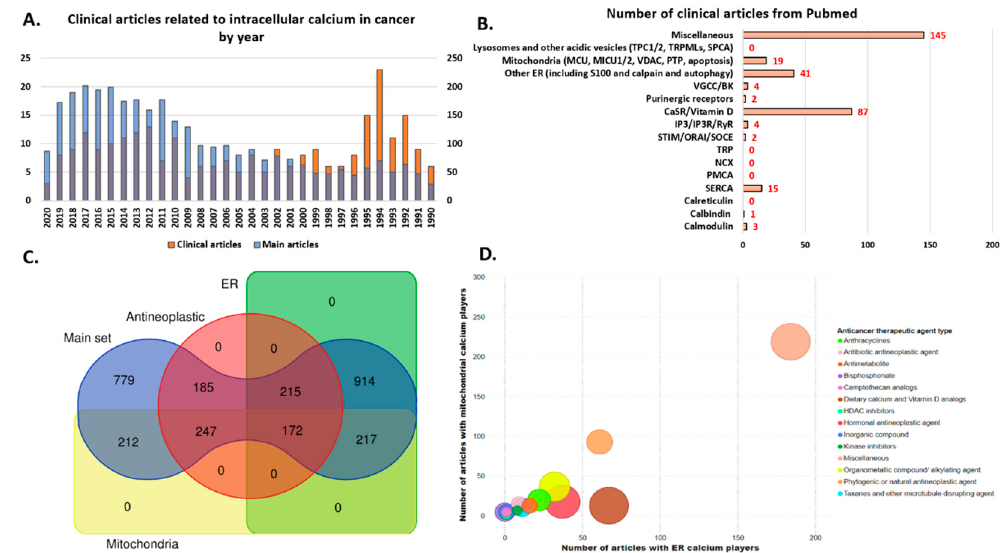
Figure 11. The focus of published clinical studies in the area of intracellular Ca 2+ in cancer. ( A ) Year-wise distribution of clinical articles (same as clinical studies in the previous figure) extracted from the published articles obtained using the revised filter. The left y-axis corresponds to clinical articles while the right y-axis is for depicting the number of main articles. ( B ) The number of extracted clinical articles categorized by the major intracellular Ca 2+ signaling molecule(s) each study is focused on. ( C ) The published articles (referred to as the main set) found using the revised filter are broken down into subsets of studies that have utilized antineoplastic agents or highlighted intracellular Ca 2+ signaling molecules either from the endoplasmic reticulum and its inter-organellar junctions or mitochondria. Venn diagram shows the overlap between the number of studies in each subset and the main set. ( D ) Bubble chart indicates the major groups of antineoplastic agents used in the clinical articles with the main intracellular signaling molecules from the endoplasmic reticulum and its inter-organellar junctions or mitochondria. The size of bubbles is proportional to the number of clinical studies documented in PubMed per anticancer therapeutic agent category.